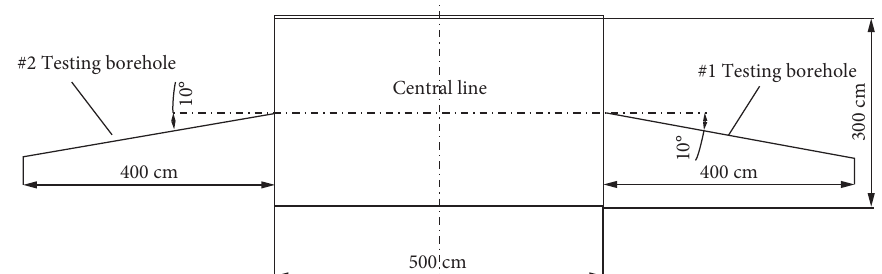
Figure 8: Arrangement of the boreholes for ultrasonic Figure 10. Two main characters can be drawn from this result: firstly, the vertical stress in the y direction of the surrounding rock shows high concentration. Secondly, the vertical stress decreases as the distance from the drilling field increases until it falls to the virgin field stress of 16 MPa at the distance around 12 m and the high vertical stress area (20–22 MPa) locates at the depth of 7-8 m. Taking the contour of 16 MPa as the boundary of the stress concentration zone, it is clear that the excavation-induced stress concentration zone reaches as far as 12 m. While, the vertical stress reaches its top (22 MPa) around the depth of 7-8 m.